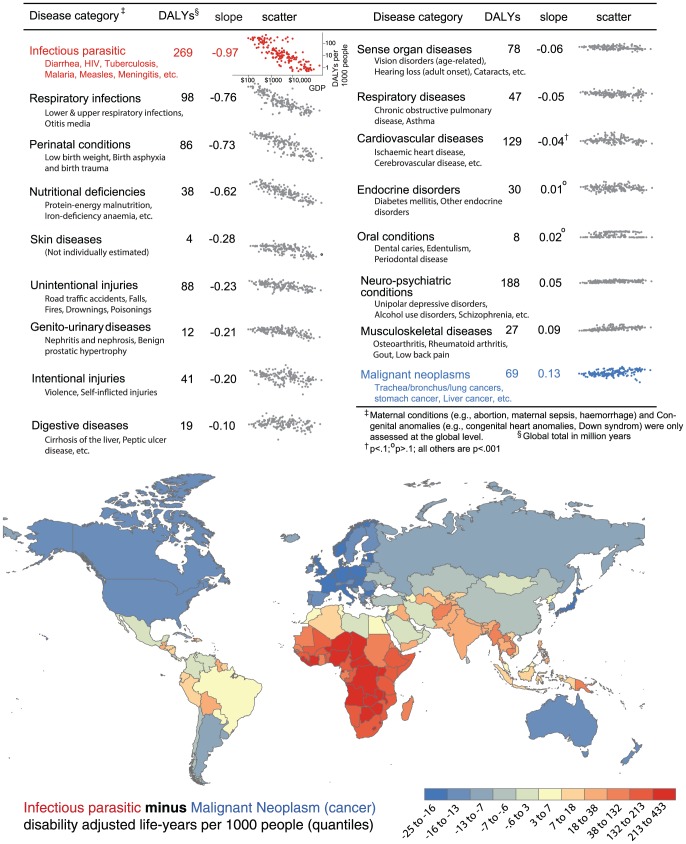
Broad disease categories, the global DALYs they exact, and the relationship between country health burden and wealth for broad disease categories.Disease subcategories (e.g., HIV/AIDS) are listed in order from those that incur the largest global health burden. Scatter plots graph country DALY rate (DALYs per 1000 people) of conditions by GDP per capita, plotted on a log scale; slopes represent this as a linear relationship (the estimated OLS coefficient of logged GDP per capita regressed on logged DALY rate). The global map illustrates country differences in disease burden by plotting the difference between DALY rate for infectious diseases and cancers, categories with the most negative and positive relationship with country wealth.